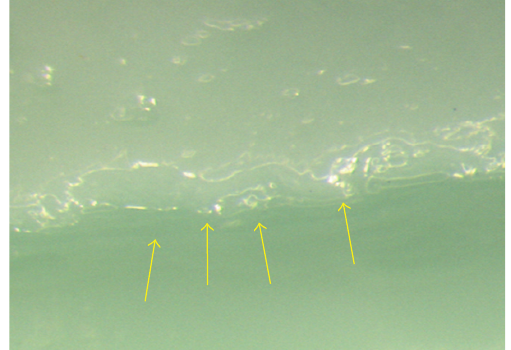
Figure 6: Magnification of the palatal aspect of Figure 5. No gap was detectable.